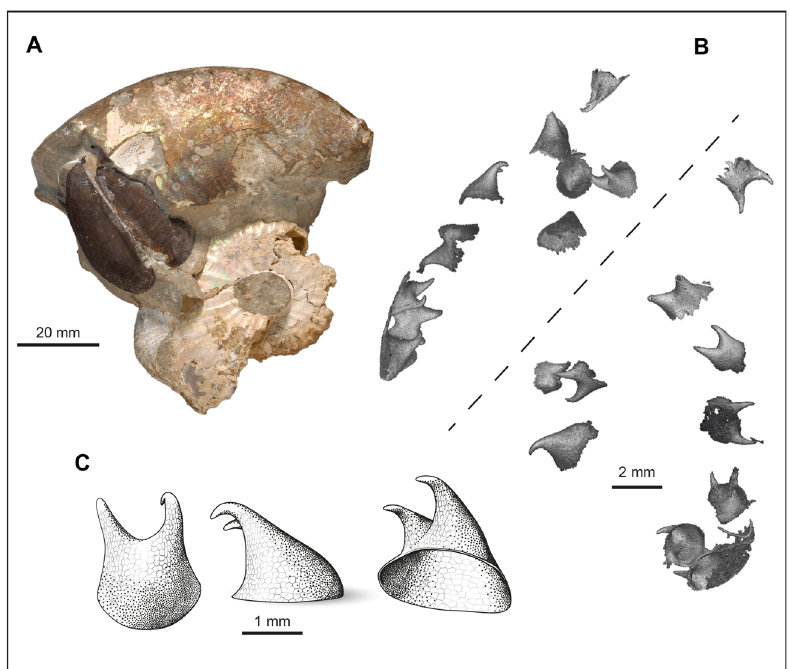
Figure 1. Hoploscaphites hooks. ( A ) H. nicolletii , AMNH 51333. Part of the phragmocone and most of the body chamber is preserved, with the jaw still in-situ testifying to the exceptional preservation. ( B ) Illustration of